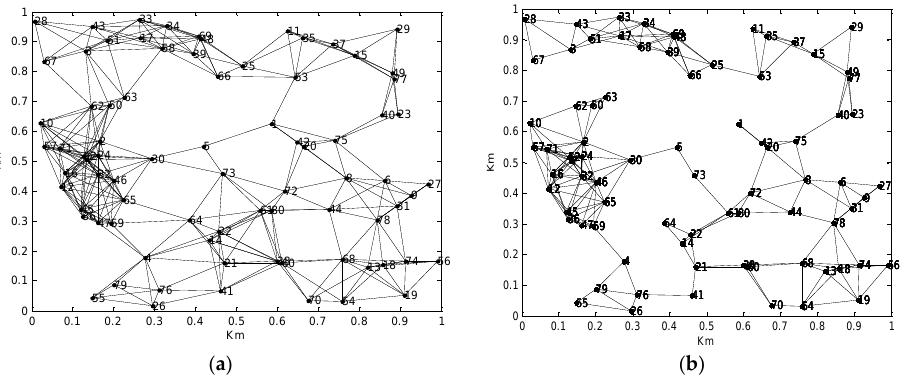
Figure 8. The simulation result: ( a ) NONE; and ( b ) energy efficient and reliable topology control algorithm (ERTC). * The X -axis and Y -axis means the node distribution area.